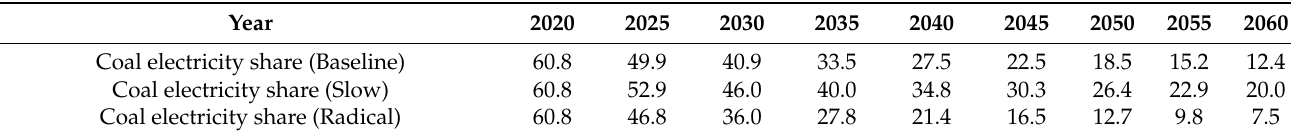
Table 15. Scenarios for coal electricity share.